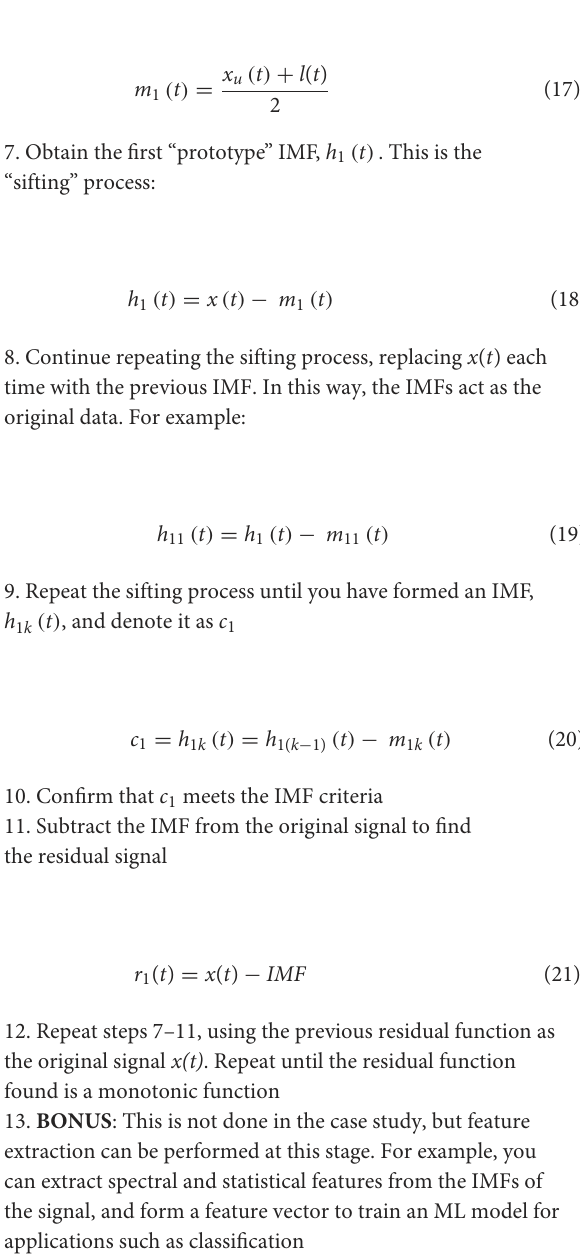
Algorithm 14. STFT algorithm (Ha,